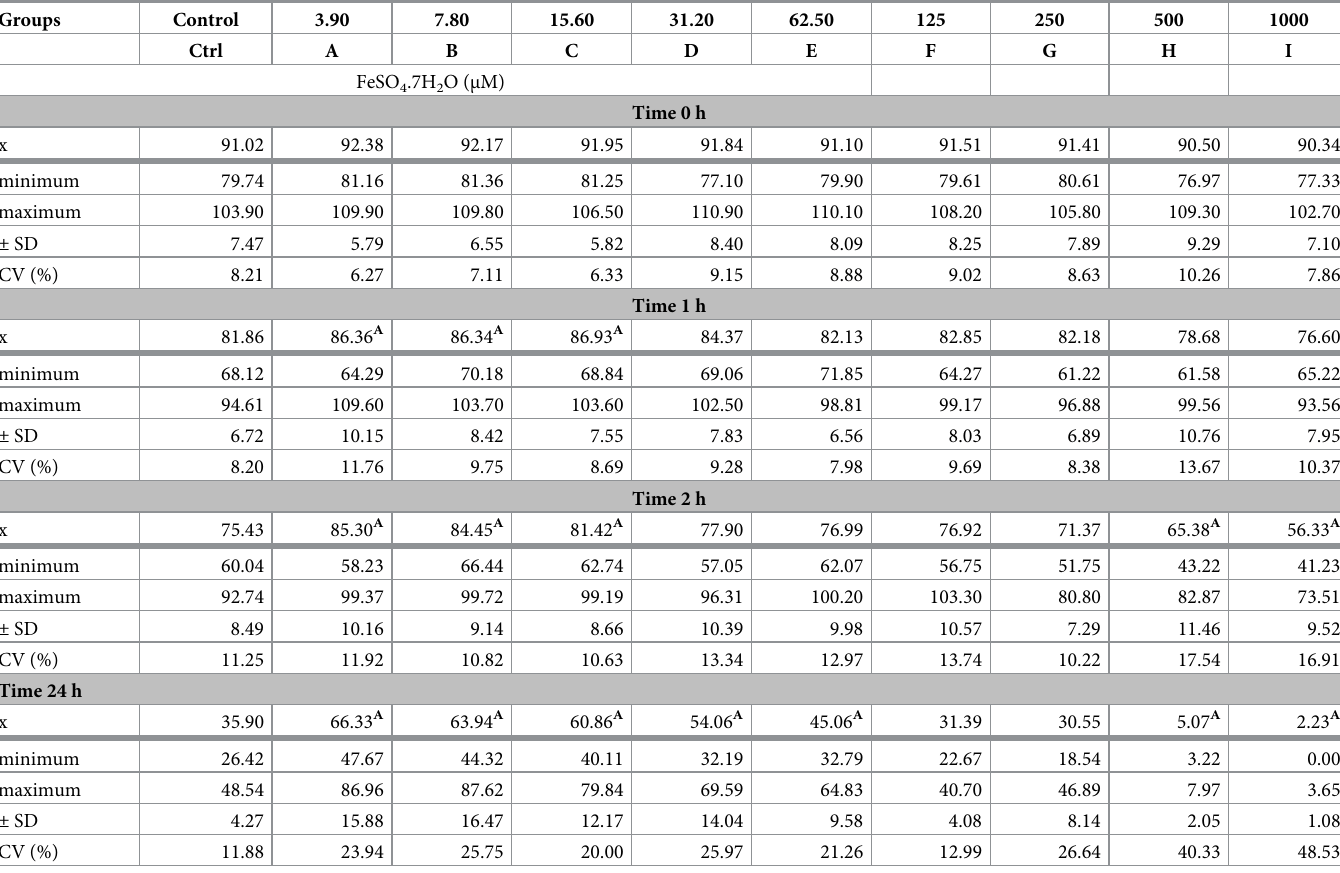
Table 3. Velocity average path of spermatozoa ( μ m/s) exposed to FeSO 4 .7H 2 O in different time periods.